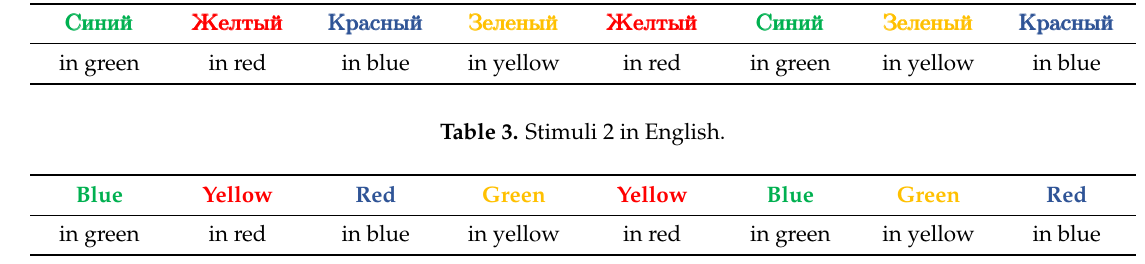
Table 2. Stimuli 1 in Russian.